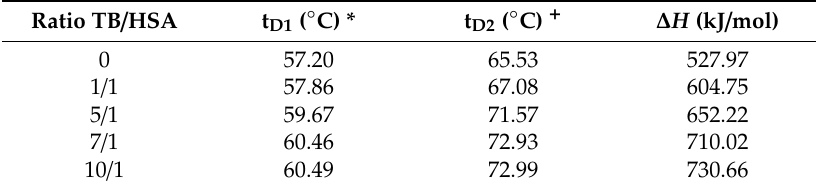
Table 1. Thermodynamic parameters of denaturing complexes of human serum albumin (HSA) and TB /